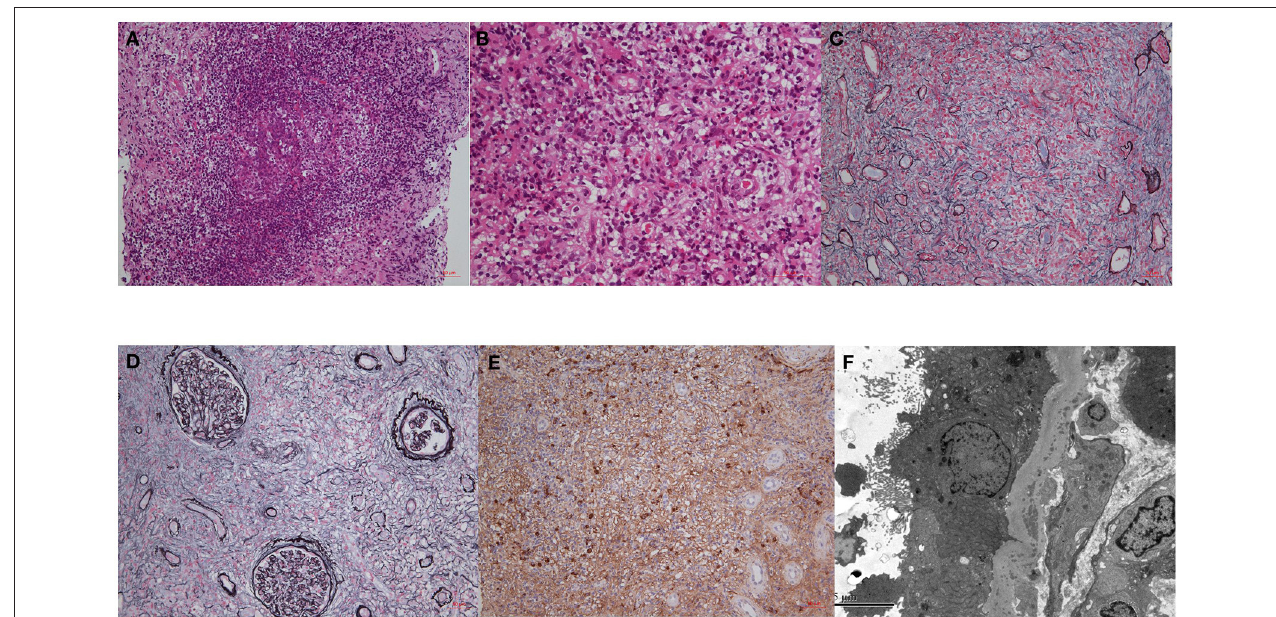
FIGURE 2 | The pathological findings of IgG4-RKD. (A) An ectopic lymphoid tissue; (B) eosinophils infiltration; (C,D) storiform fibrosis; (E) IgG4-possitive staining plasma cells. (F) TBM deposits by